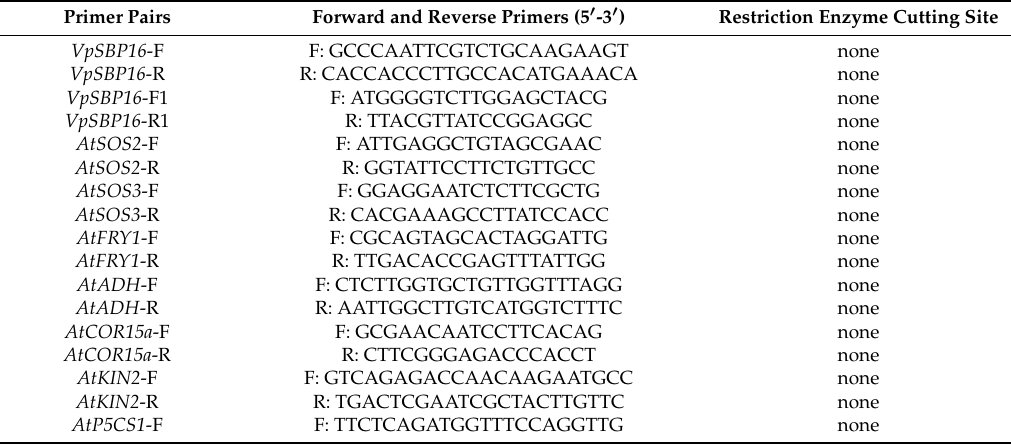
Table 1. The information of primers used in this paper. F indicates forward primer, R indicates reversed primer and the underline indicates restriction sites.